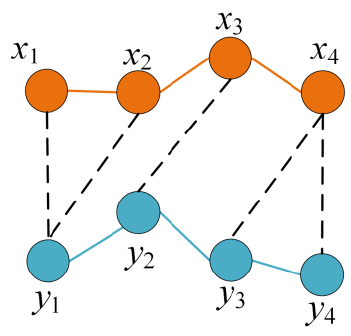
Figure 10. The calculation principle of DTW.